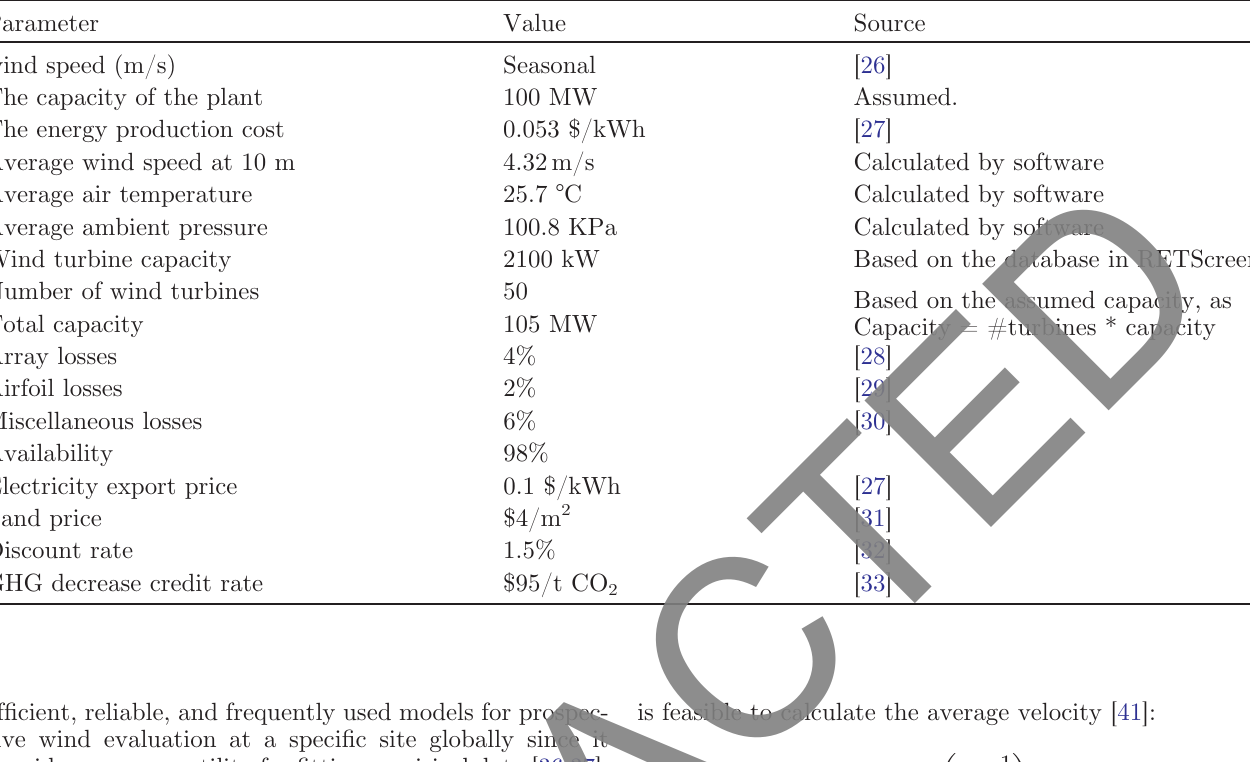
Table 1. Initial and assumed parameter